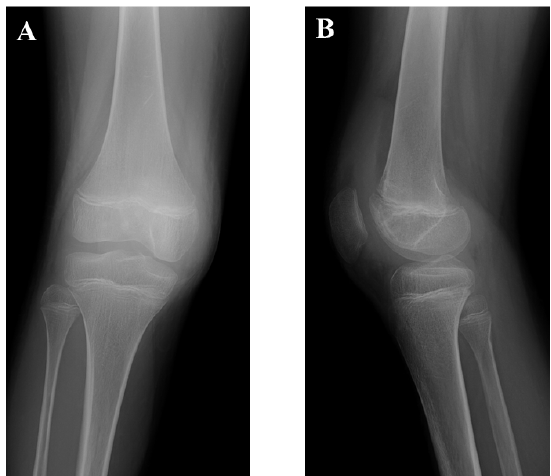
Figure 1. Plain radiographic findings at initial presentation. Anteroposterior view ( A ). Lateral view ( B ). The knee physes were open.